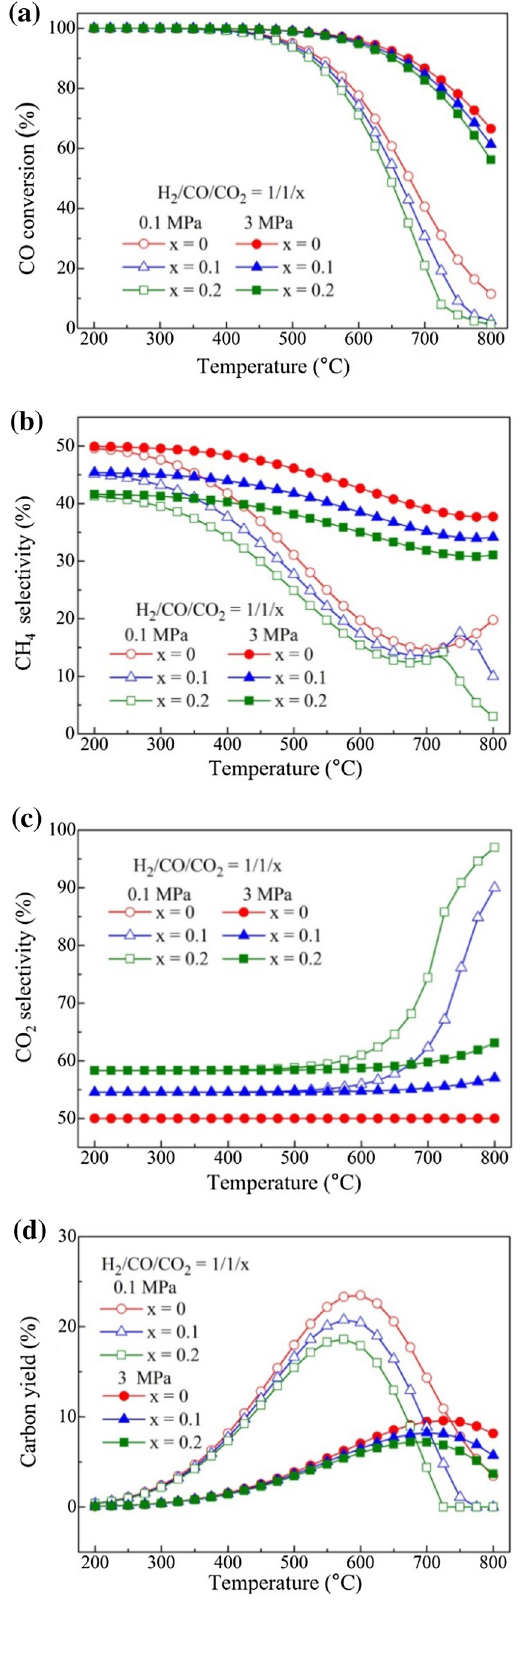
c Fig. 7 Effect of CO